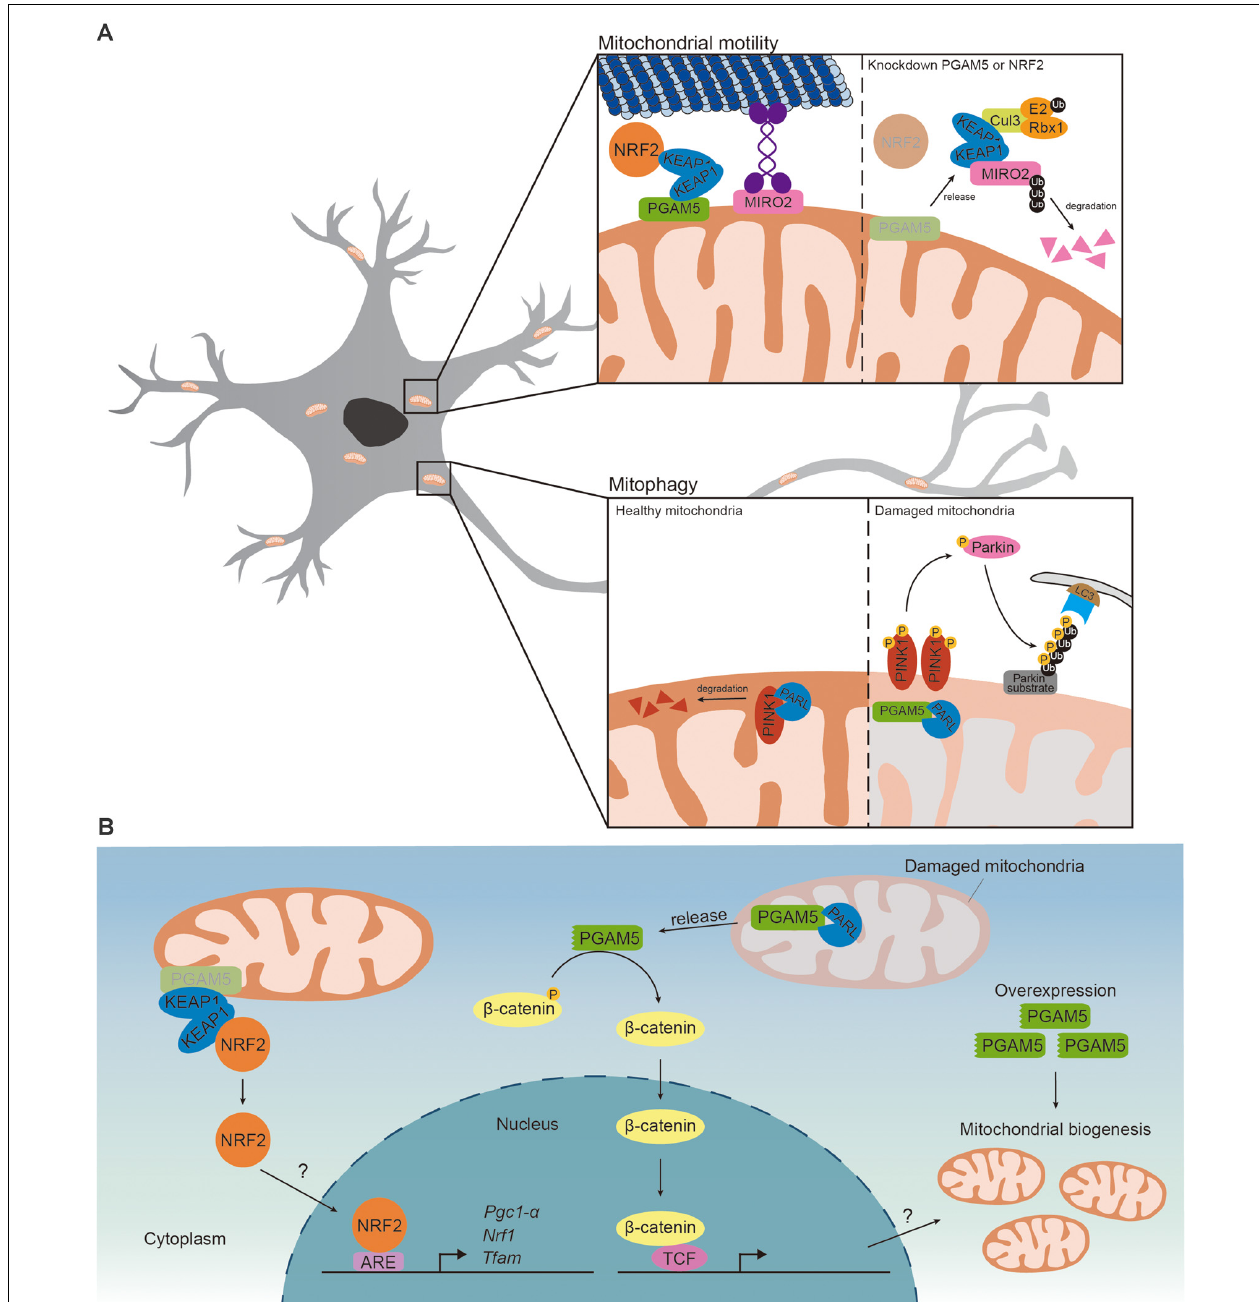
FIGURE 2 | PGAM5 regulates mitochondrial motility and mitophagy. (A) (Upper) In the presence of PGAM5-KEAP1-NRF2 complex on the MOM, Miro2 would link kinesin to the MOM and regulate mitochondrial retrograde trafficking induced by proteasome inhibition. While knockdown of PGAM5 or NRF2, KEAP1 is released from the complex and free KEAP1 couples with Cul3 forming ubiquitin complex and result in degradation of Miro2 resulting in the inhibition of mitochondrial retrograde trafficking. (Lower) PINK1 is transported to MIM and degraded by PARL in healthy mitochondria. In damaged mitochondria, PARL cleaves PGAM5, instead of PINK1, which stabilizes PINK1 on MOM. Accumulation of PINK1 would recruit Parkin to ubiquitylate Parkin substrates on MOM. The autophagosome with LC3 and autophagy receptor would then be recruited to trigger Parkin-mediated mitophagy. (B) (Left) PGAM5-KEAP1-NRF2 complex restricts NRF2 to mitochondria and represses NRF2-dependent transcription. Upon knockdown of PGAM5, NRF2 translocates to the nucleus and activates NRF2-dependent transcription. But whether PGAM5 inhibits mitochondrial biogenesis via repressing NRF2-dependent transcription is unclear. (Right) When mitochondria sense stress signal, PGAM5 is cleaved by PARL and released to cytoplasm. Cleaved PGAM5 dephosphorylates β -catenin and activates β -catenin-dependent transcriptions. Overexpressing cleaved PGAM5 promotes mitochondrial biogenesis. However, whether PGAM5 promotes mitochondrial biogenesis via β -catenin-dependent transcriptions remains